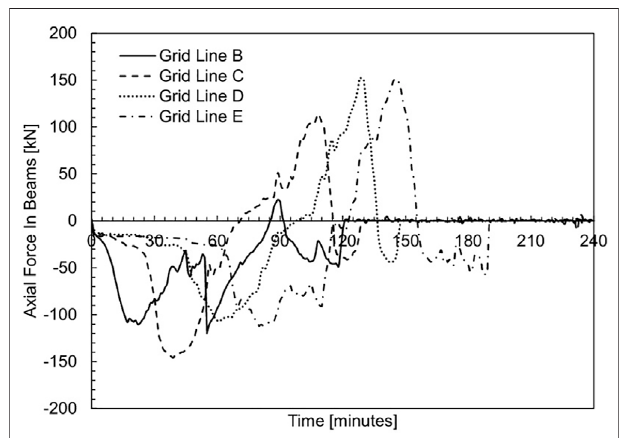
FIGURE 13 | Axial force histories of secondary beams spanning between MRF and gravity columns in Fire Scenario #2.